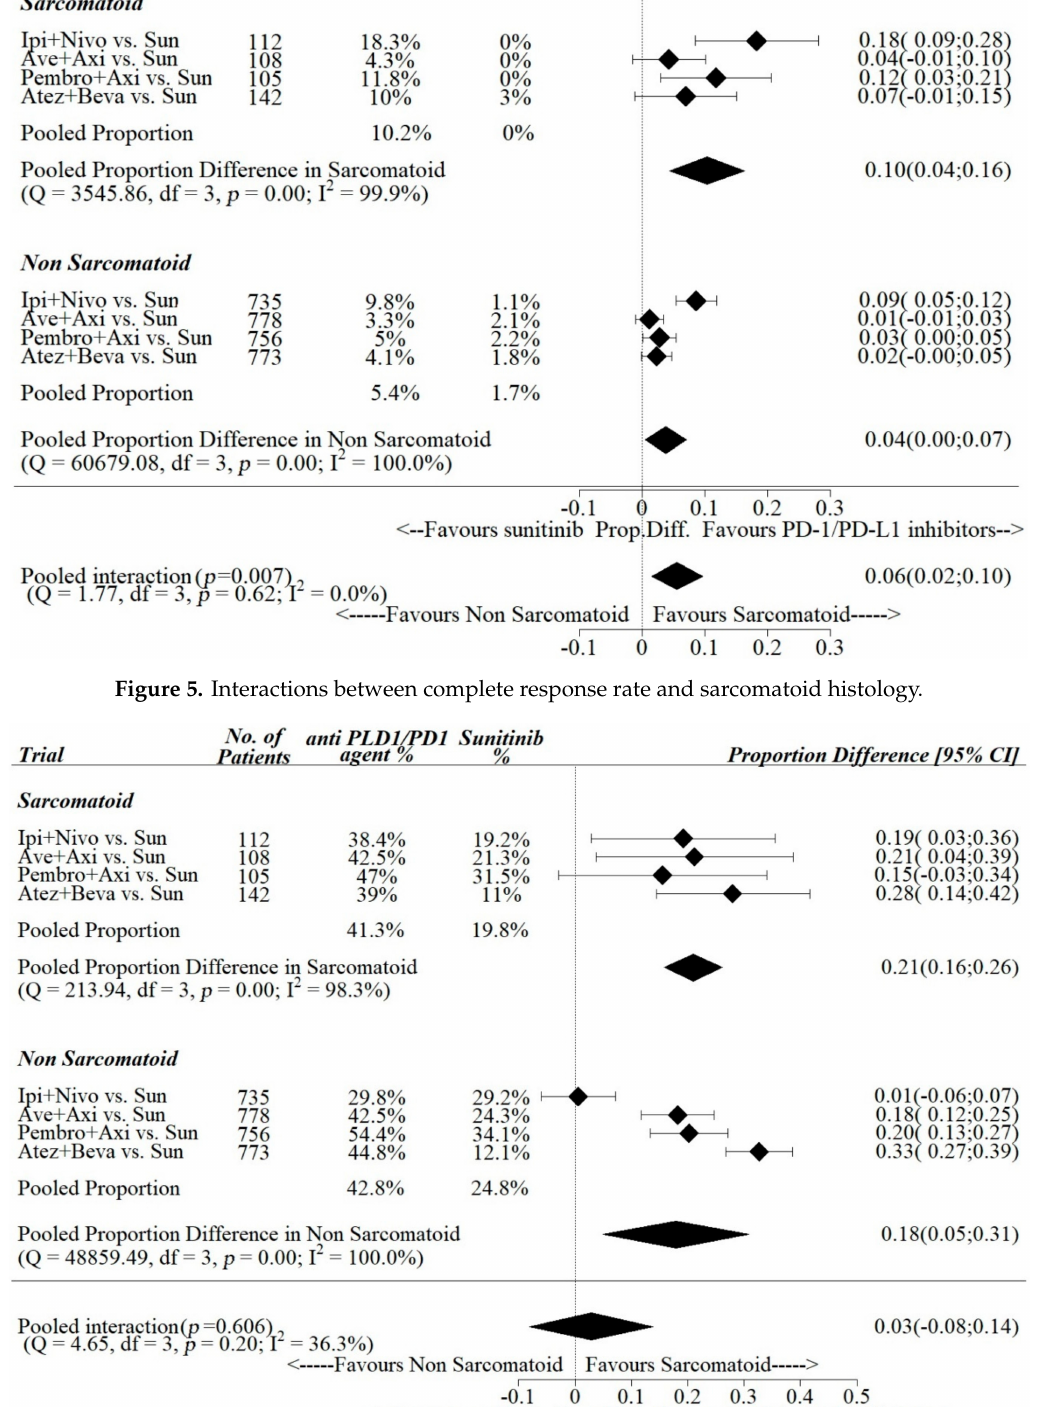
Figure 6. Interactions between partial response rate and sarcomatoid histology. The pooled di ff erences in the sarcomatoid vs. non-sarcomatoid sub groups of ∆ CR-R and ∆ PR-R between anti PD-1 / PDL-1 vs. sunitinib were 0.06 (95% CI: 0.02–0.10) and 0.03 (95% CI: 0.08–0.14), respectively. Pooled interaction was statistically significant for complete responses ( p